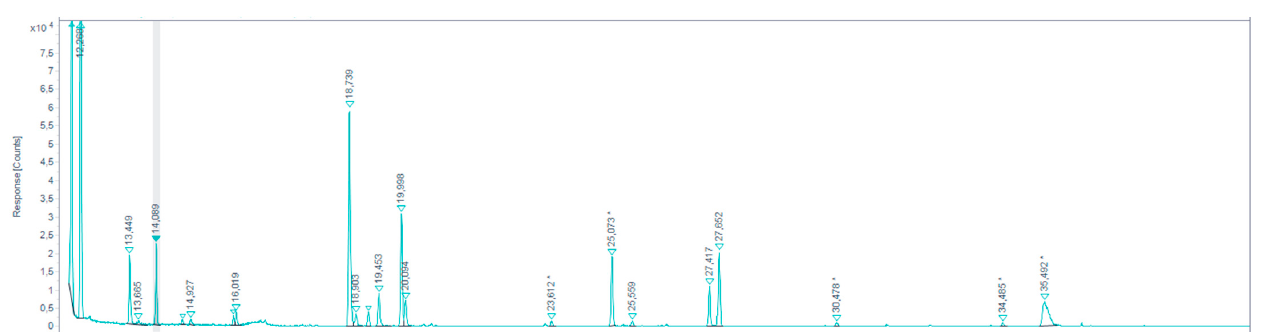
Figure 8. Total ion chromatogram (TIC) for aqueous chicken meat extract sample extracted by HS- SDME on PFBHA droplet (up) and the extracted-ion chromatogram (EIC) 180.7–181.7 EI (down) (* indicates that the peak has been manually integrated). Table 6. Identification of carbonyl compounds in overcooked chicken meat aqueous extract ex- tracted by HS-SDME on PFBHA droplet, based on RT, KRI, and fragmentation.